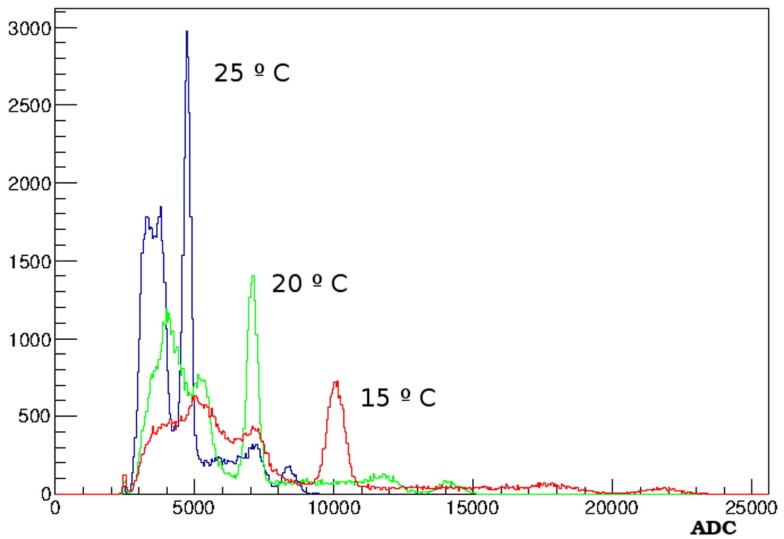
22Na spectra obtained at different temperatures where one can see the gain variation.